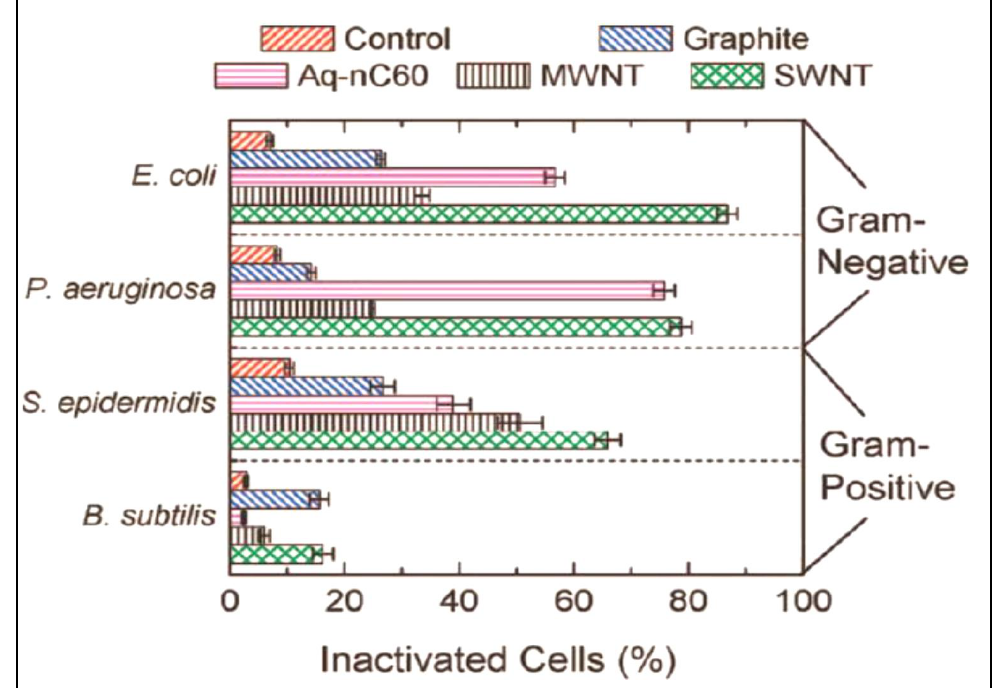
Figure 7. The schematic of fluorescence-based toxicity assays in the presence of different type of CNT against gram positive and negative bacteria. Reprinted with permission from referenced Kang et al. (2009). Acknowledged and cited [61,80] (Reproduced with permission and cited in references, ACS Chemical Socitey).